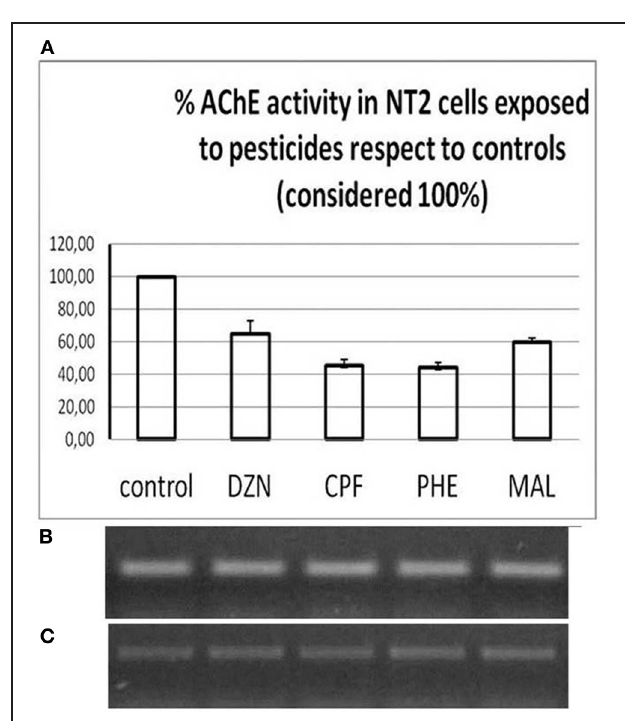
FIGURE 11 | NT2 cells exposed to 10 − 5 M inhibitors. (A) Changes in AChE activity; (B) Corresponding AChE mRNA (538bp) amounts; (C) Actin expression (259bp). DZN, diazinon; CPF, chlorpyrifos; PHE, phenthion; MAL, malathion.